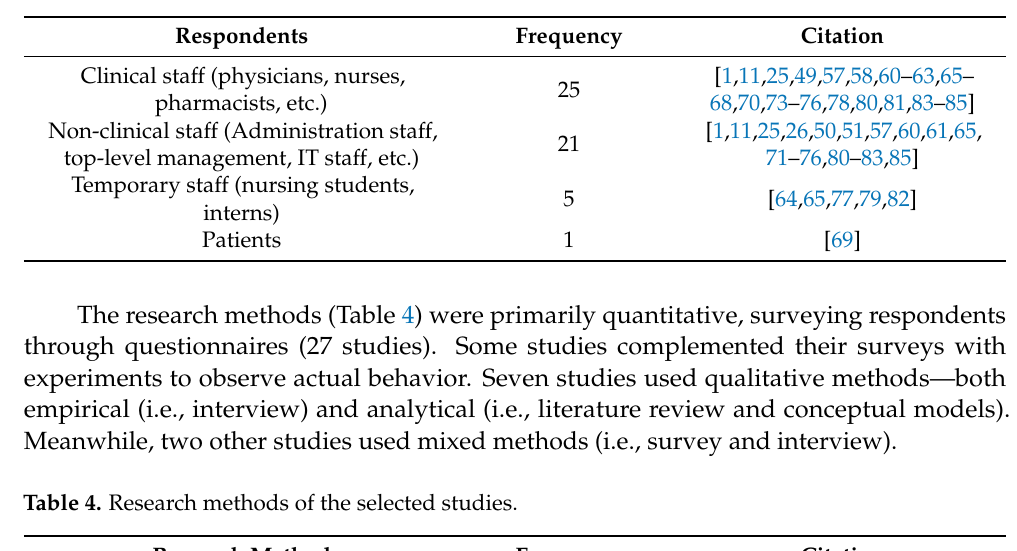
Table 3. Respondents involved in the selected studies.